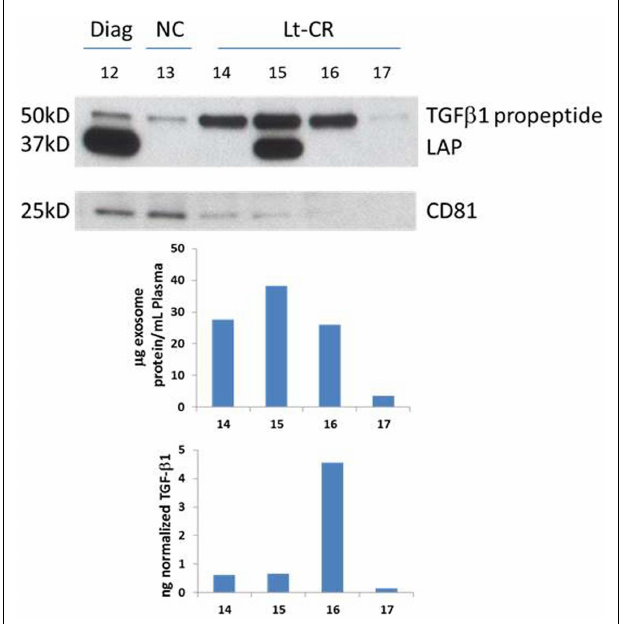
FIGURE 4 |TGF- β 1 profiles of four patients in long-term clinical remission .Western blots forTGF- β 1 and CD81, an exosomal marker, were performed as described in the Section “Materials and Methods.” Few exosomes were recovered from the plasma of patient #17, as indicated by a nearly absent CD81 signal.Western blots of exosomes isolated from plasma specimens of a representative AML patient and a NC are included for comparisons. Protein levels and solubleTGF- β 1 levels were measured in the same exosomes and the respective values are shown